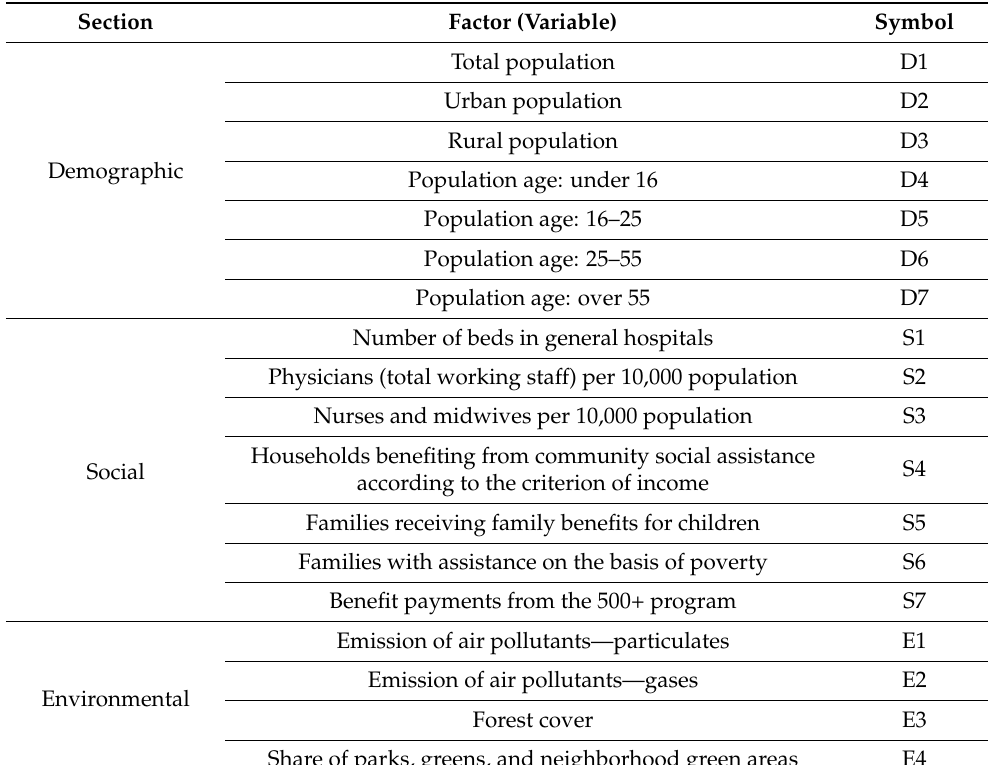
Table 1. Selected demographic, social, and environmental factors. Source: own elaboration on the basis of data from Statistics